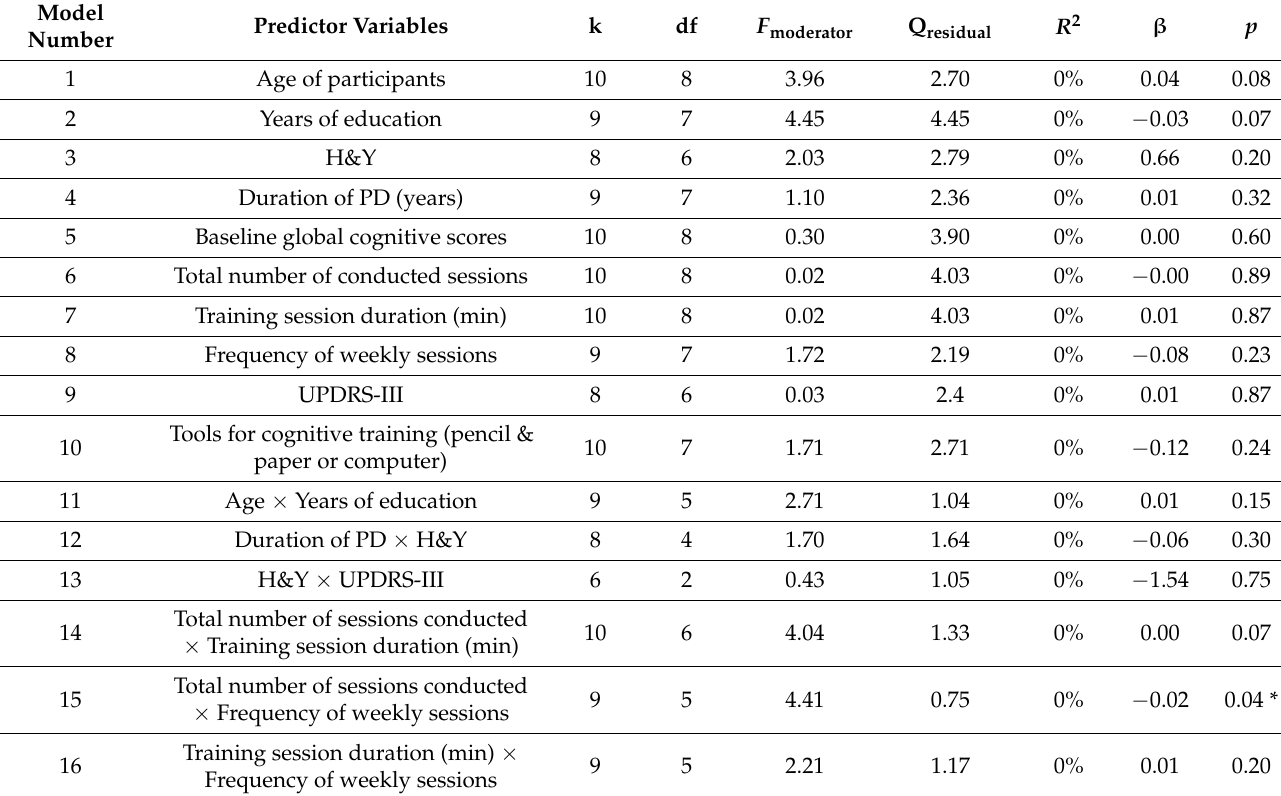
Table 2. Results of overall cognitive function meta-regression Table 2 . Results of overall cognitive function meta-regression analyses.